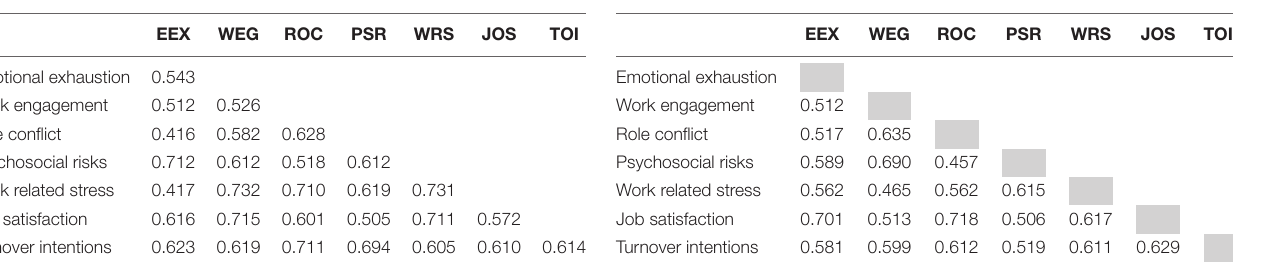
TABLE 2 | Heterotrait-monotrait (HTMT).